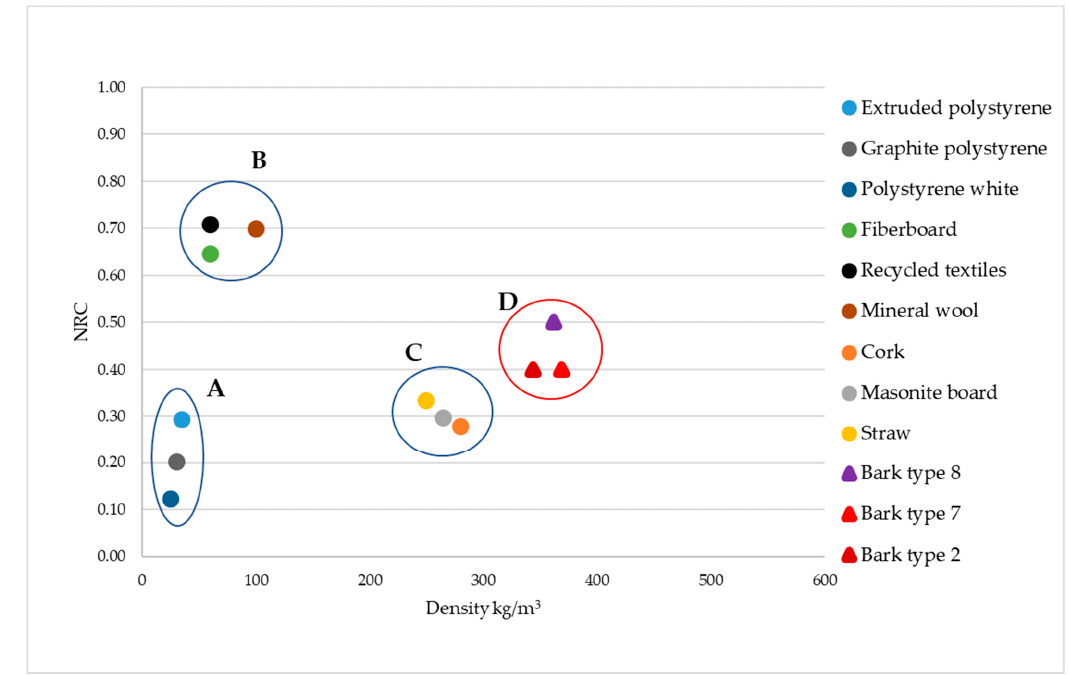
Figure 6. The NRC value of selected materials depending on the density of the tested material ( A –polystyrene based materials, B –typical sound-insulating materials, C –cellulose-based insulations, D –bark-based boards). From Figure 6, it can be observed that polystyrene-based materials (extruded, white and graphite polystyrene), which are grouped in area A, have a very low density (25 to 35 kg/m 3 ), and their NRC values range from 0.1 to 0.3. Area B contains typical sound-insu-